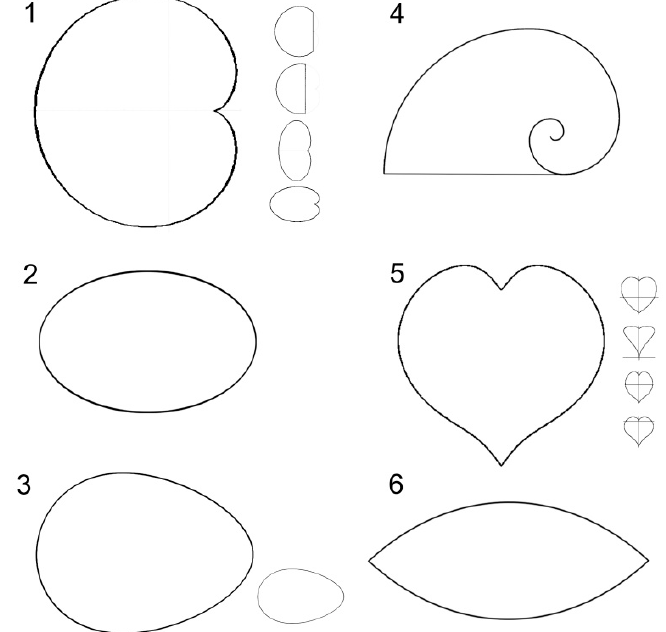
Figure 1. Main models used in the description and quantification of seeds. ( 1 ) Cardioid and derivatives; ( 2 ) ellipse; ( 3 ) oval and elongated oval; ( 4 ) the contour of Fibonacci’s spiral; ( 5 ) heart-shaped curves; ( 6 ) lens.